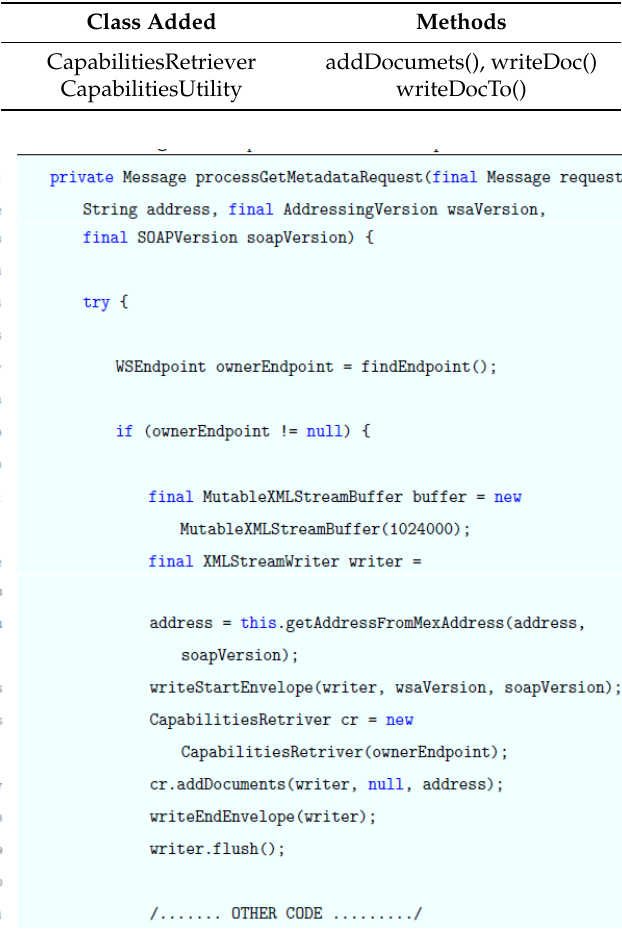
Figure 6. The processGetMetadataRequest method.